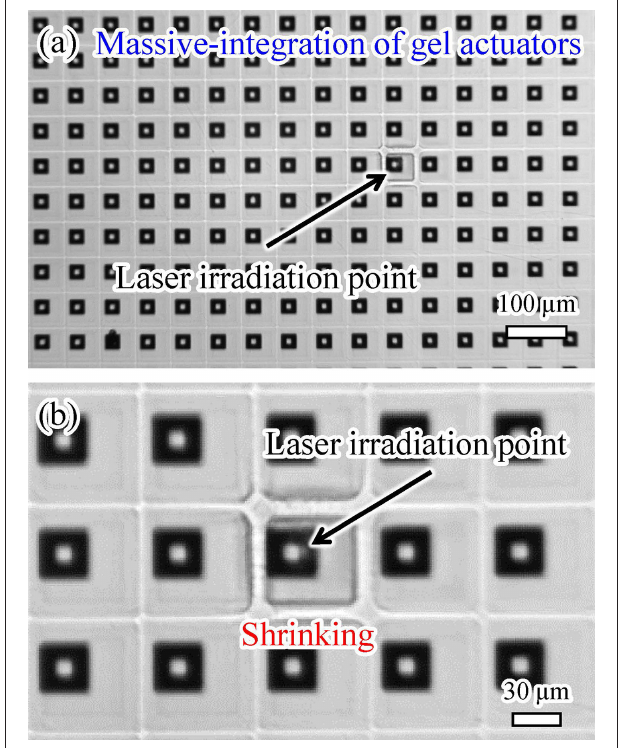
FIGURE 11 | Massive integration of gel actuators: (a) overall view and (b) enlarged